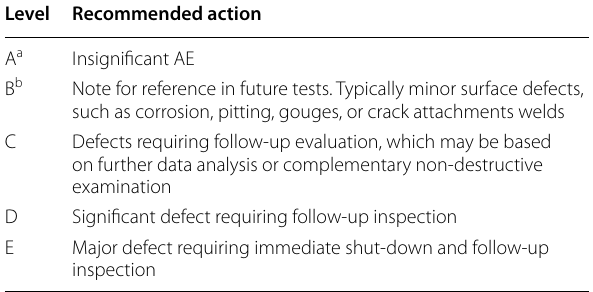
Table 2 Significant of intensity zones (Gostautas et al.,